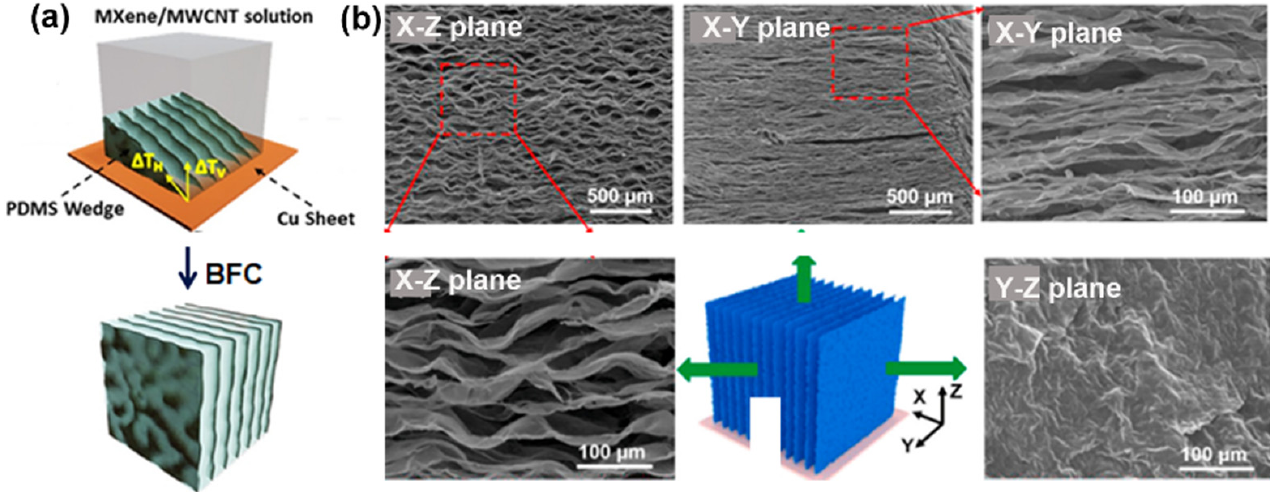
Figure 8. ( a ) Schematic illustration of BFC device and process. ( b ) SEM images of Ti 3 C 2 T x /PI aerogel with long-range ordered lamellar structure captured from different views. ( a ) is reproduced with permission from ref. [60]. Copyright 2019, American Chemical Society. ( b ) is reproduced with permission from ref. [54]. Copyright 2020, Elsevier.